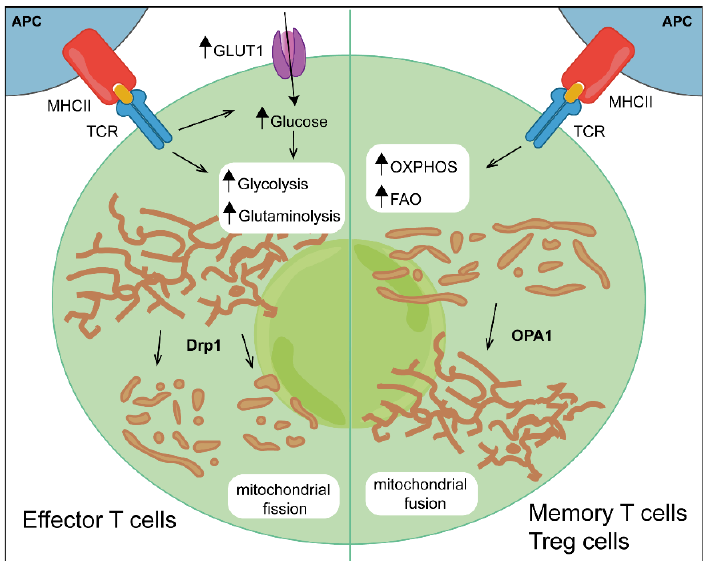
Figure 1. Mitochondrial metabolism and dynamics determine T-cell differentiation. Increasing aer- obic glycolysis and glutaminolysis leads to a pro-inflammatory effector phenotype, whereas stimuli that promote OXPHOS and mitochondrial respiration boost the differentiation of regulatory and memory T cells. Morphological changes in the mitochondria also control metabolic reprogramming: the mitochondria of effector T cells undergo fission regulated by the GTPase dynamin-related protein 1 (Drp1), while regulatory and memory T cells maintain a fused mitochondrial network supported by protein Optic atrophy 1 (Opa1). FAO, fatty acid oxidation.